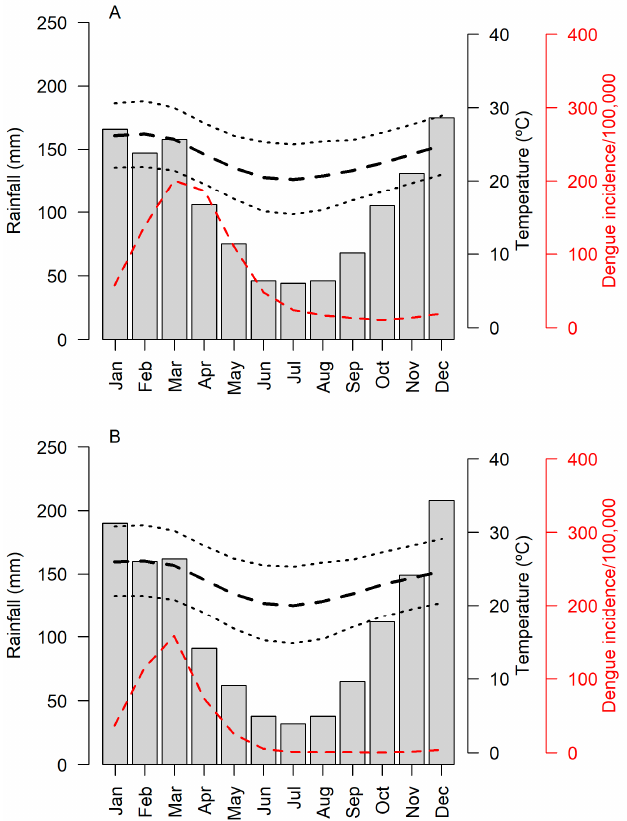
Figure 2. Climate and dengue transmission in ( A ) Itaboraí and ( B ) Cachoeiras de Macacu. Gray bars represent monthly accumulated rainfall. Solid and dashed black lines represent mean and minimum and maximum temperatures (°C). Red lines represent mean monthly dengue incidence from 2001–2019 (cases per 10,000 inhabitants) (Source: Sistema de Informação de Agravos de Notificação—SINAN).